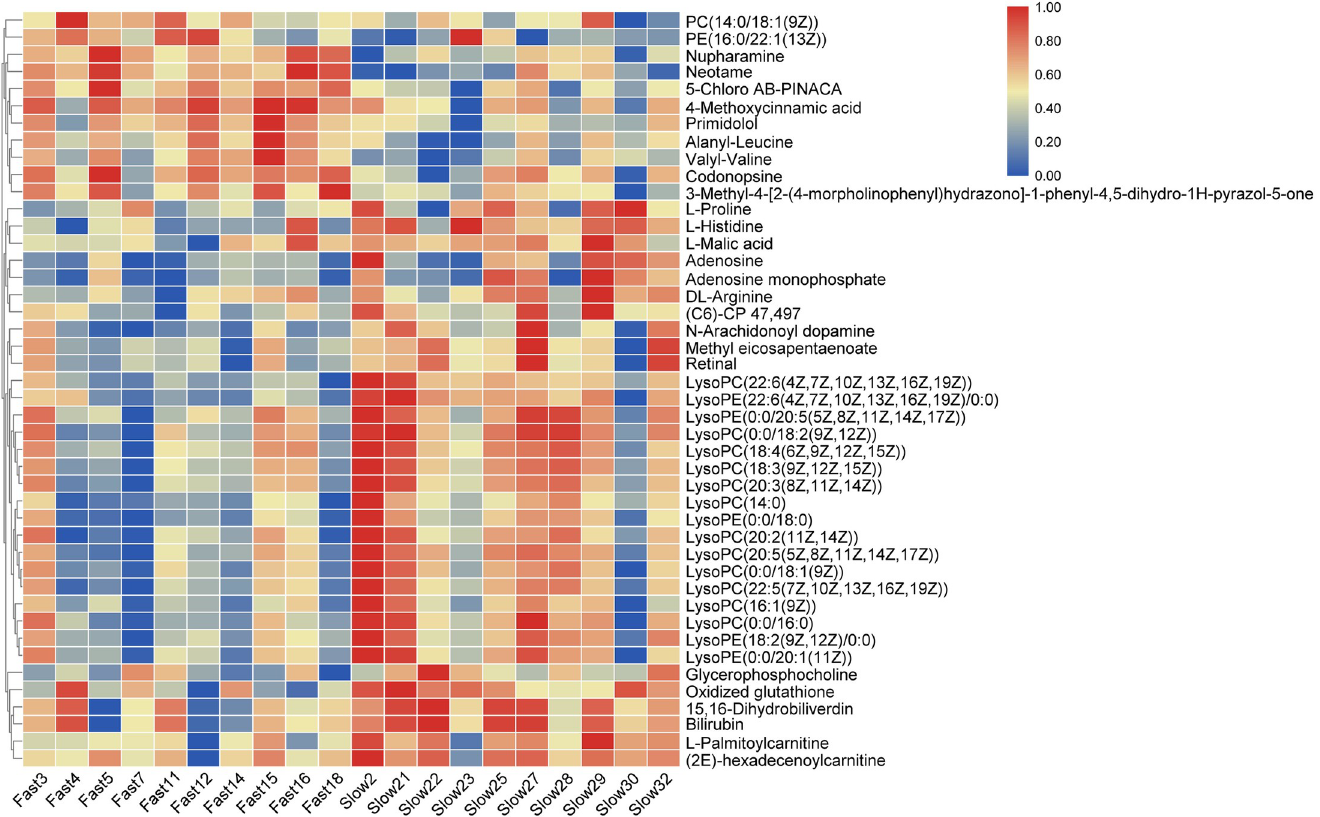
Fig 3. Heatmap of significantly differential metabolites between the fast-growing and slow-growing groups.